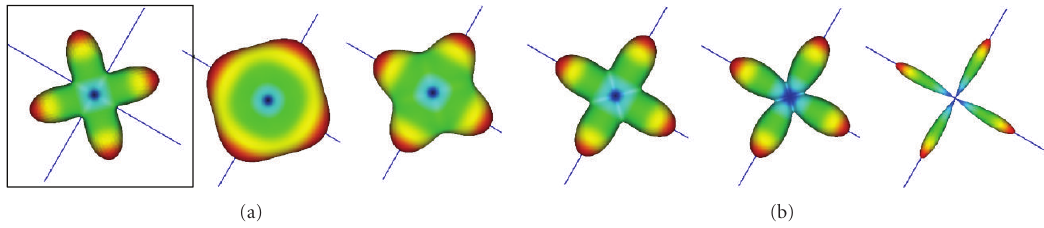
Figure 1: Spherical profiles of (a) the (cid:2) ADC estimated from the modified GDTI with a 4th-order tensor and (b) EAP approximation, P ( r ) (7) with increasing | r | from 12 μ m to 20 μ